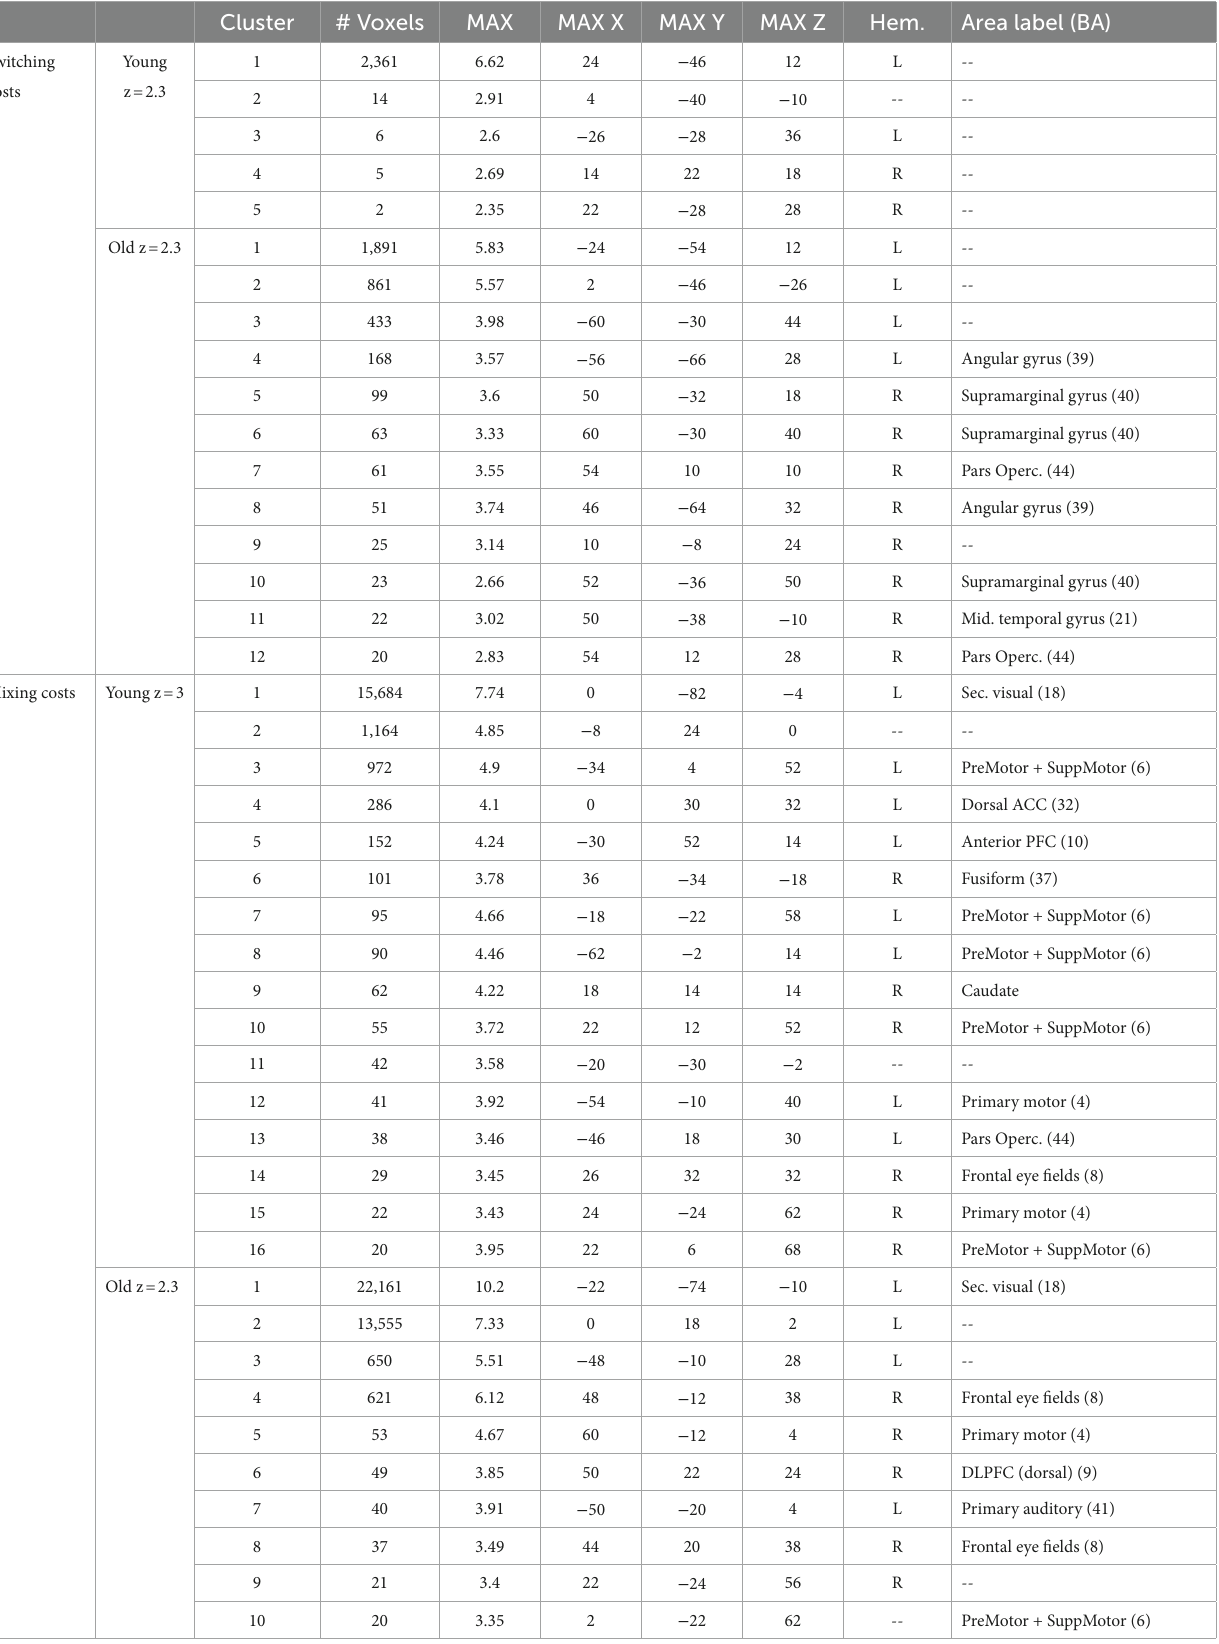
TABLE 2 Clusters of activation for switching and mixing costs, separately for younger and older adults. Cluster # Voxels MAX MAX X MAX Y MAX Z Hem. Area label